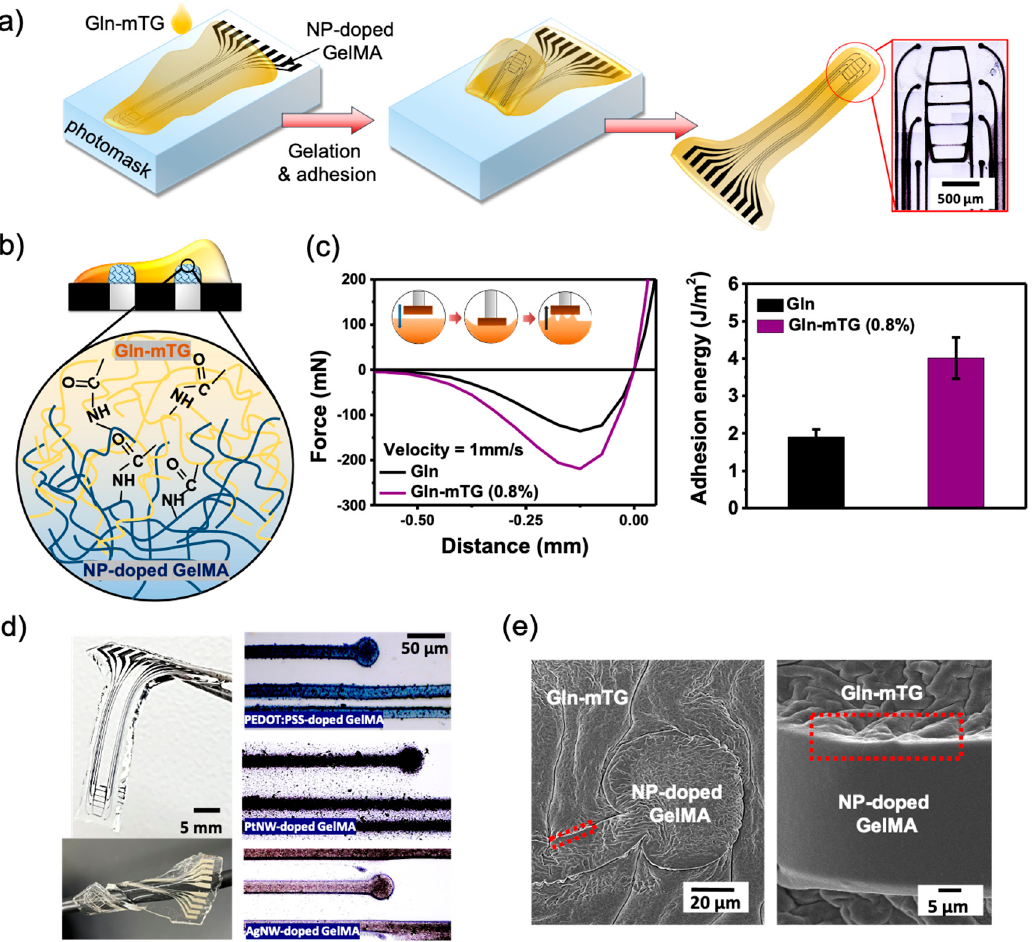
Figure 5. Transfer printing fabrication of Gln hydrogel MEA. ( a , b ) Schematic representation illustrating the mechanisms that enable one-step transfer printing microelectrode patterns of NP-doped GelMA to Gln-mTG hydrogels. ( c ) Representative force–distance curves obtained by retracting the indenter from the surface of Gln and Gln-mTG. ( d ) The naked views of the as-fabricated adhesive hydrogel MEA, which entangles around a wire with 3 mm in diameter. Optical images showing the enlarged views of NP-doped GelMA microelectrodes patterning on the Gln-mTG. ( e ) Scanning electron microscopic images of the hydrogel MEA showing continuous interfaces in the bonding area.